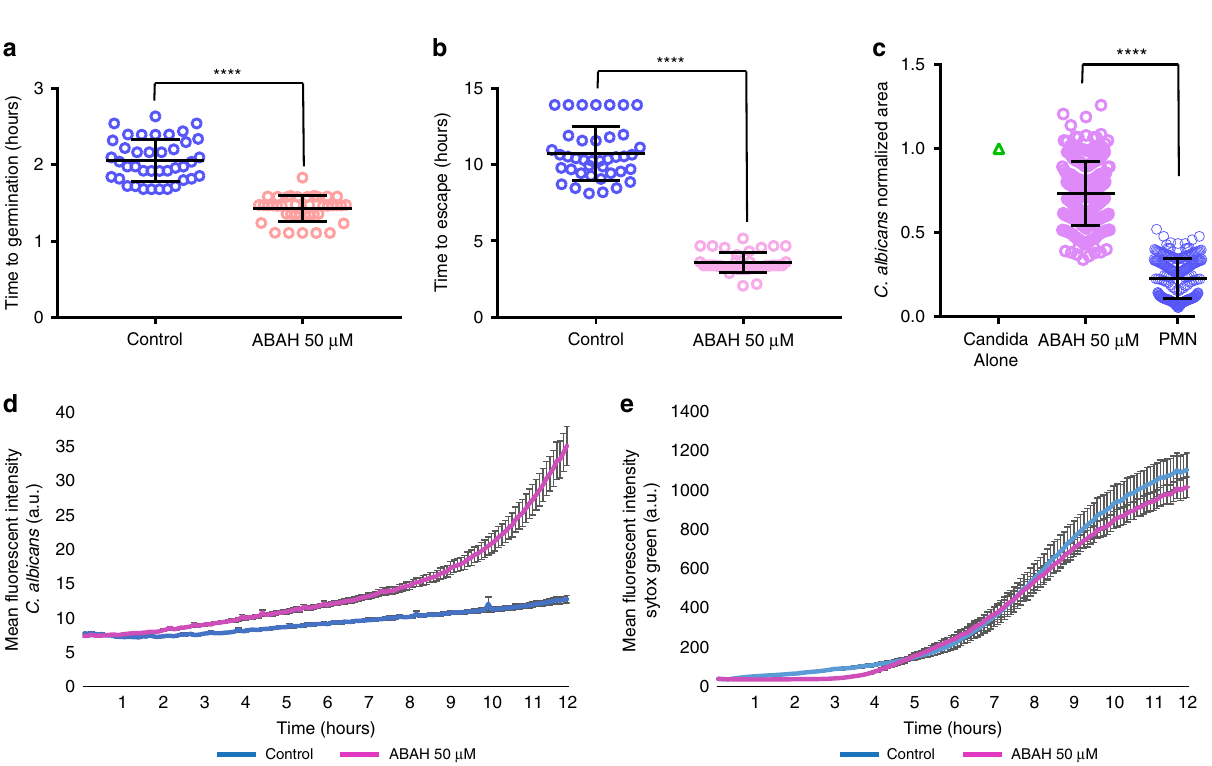
Fig. 5 Myeloperoxidase function is important during swarming control of C. albicans germination and growth. C. albicans germinates faster in swarms treated with ABAH. N = 40 swarms across 3 donors ( a ). Fungal hyphae escape faster in swarms during MPO inhibition. N = 40 swarms across 3 donors ( b ). MPO inhibition results in more fungal growth at 16 hours. Results are normalized to the growth of the C. albicans alone control. N = 240 swarms over 3 donors ( c ). The MFI of C. albicans was quanti fi ed over 12 hours with and without MPO inhibition. N = 16 swarms from a representative donor ( d ). MPO inhibition does not impact NET release during swarming. The MFI of Sytox Green was quanti fi ed over 12 hours. N = 16 swarms from a representative donor ( e ). **** p <0.0001 Students T-test for a – b , two-tailed Mann-Whitney test for c (unpaired, two-tailed). Error bars represent mean + / − standard deviation for ( a – c ) and mean + / − standard error for ( d – e ).